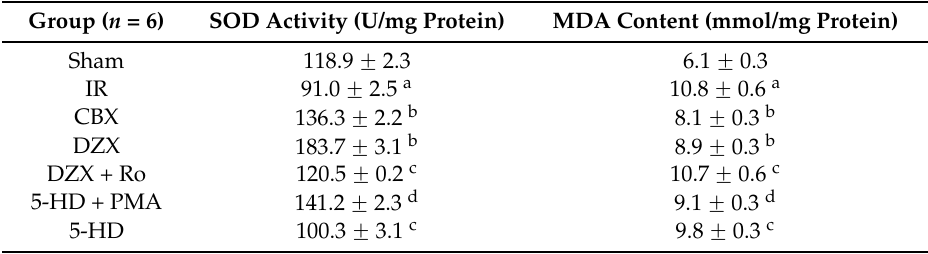
Figure 5. Effects of interference on mitochondrial function in the rat cerebral cortex. ( A ) The SOD activity in different groups; ( B ) The MDA content in different groups. Data are presented as mean ± standard deviation, n = 6 in each group; a p ≤ 0.05 vs. Sham; b p ≤ 0.05 vs. IR; c p ≤ 0.05 vs. DZX; d p ≤ 0.05 vs. 5-HD. 5-HD: 5-hydroxydecanoic acid; CBX: carbenoxolone; DZX: diazoxide; IR: ischemia-reperfusion; MDA: malondialdehyde; PMA: phorbol-12-myristate-13-acetate; Ro: Ro-31-8425; SOD: superoxide dismutase. Table 1. The activity of SOD and MDA content in different